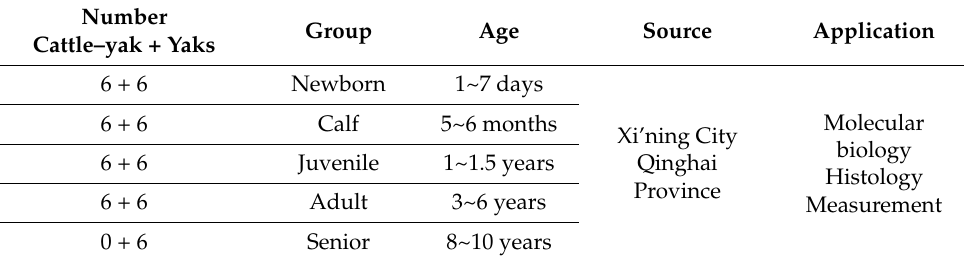
Table 1. Source and quantity of experimental